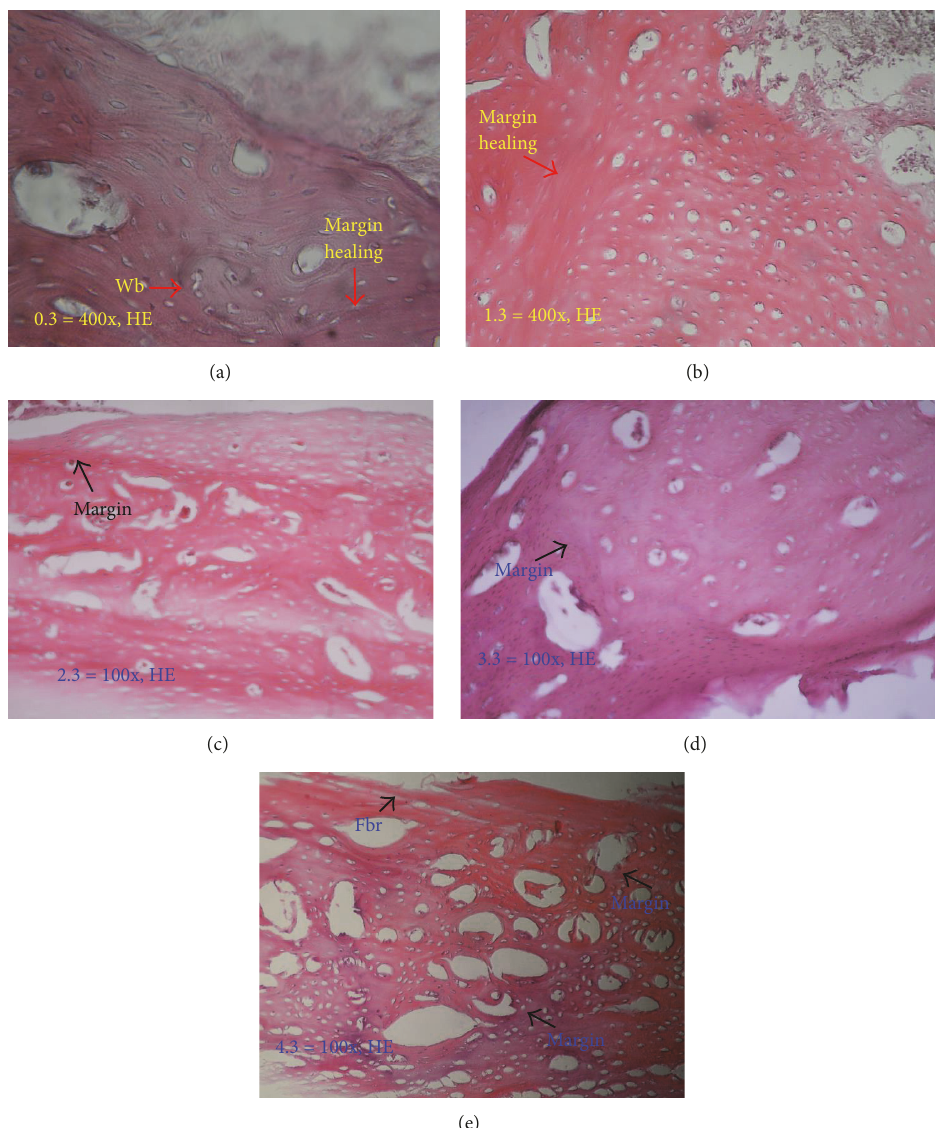
Figure 15: Histology in week 4. Clear margin between healing process and native bone shown in control group (a); freeze-dried bovine cortical group (b); allograft freeze-dried cortical New Zealand white rabbit group (c); and hydroxyapatite bovine group (d). In other hand, the healing in demineralized bone matrix bovine group (e) already resembles the native bone. Fbr: fibrous